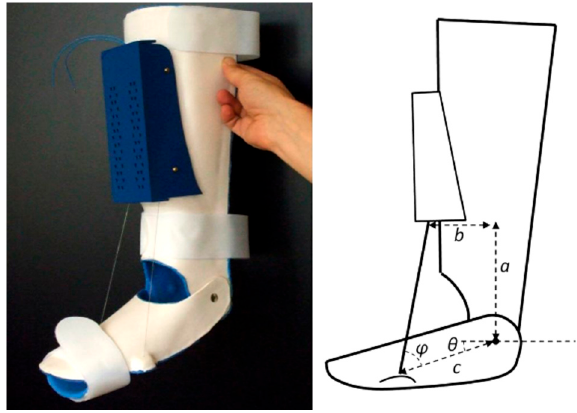
Figure 33. Implementation of an exerciser for the ankle joint with an SMA based actuator [60].